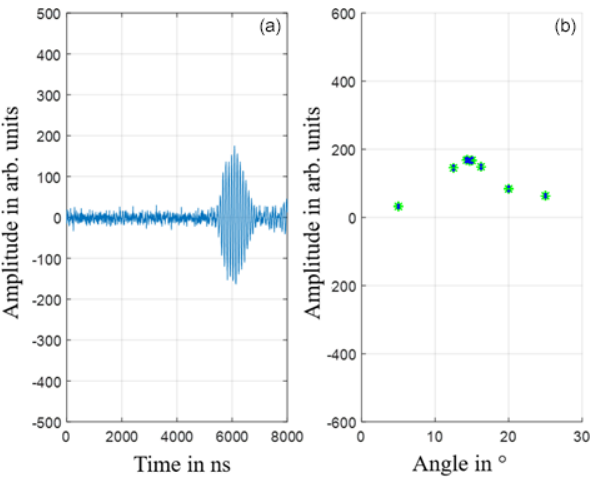
Figure 8. A scan of (amplitude over time) of a Lamb wave (a) . Search pattern for the highest amplitude dynamic (b) .